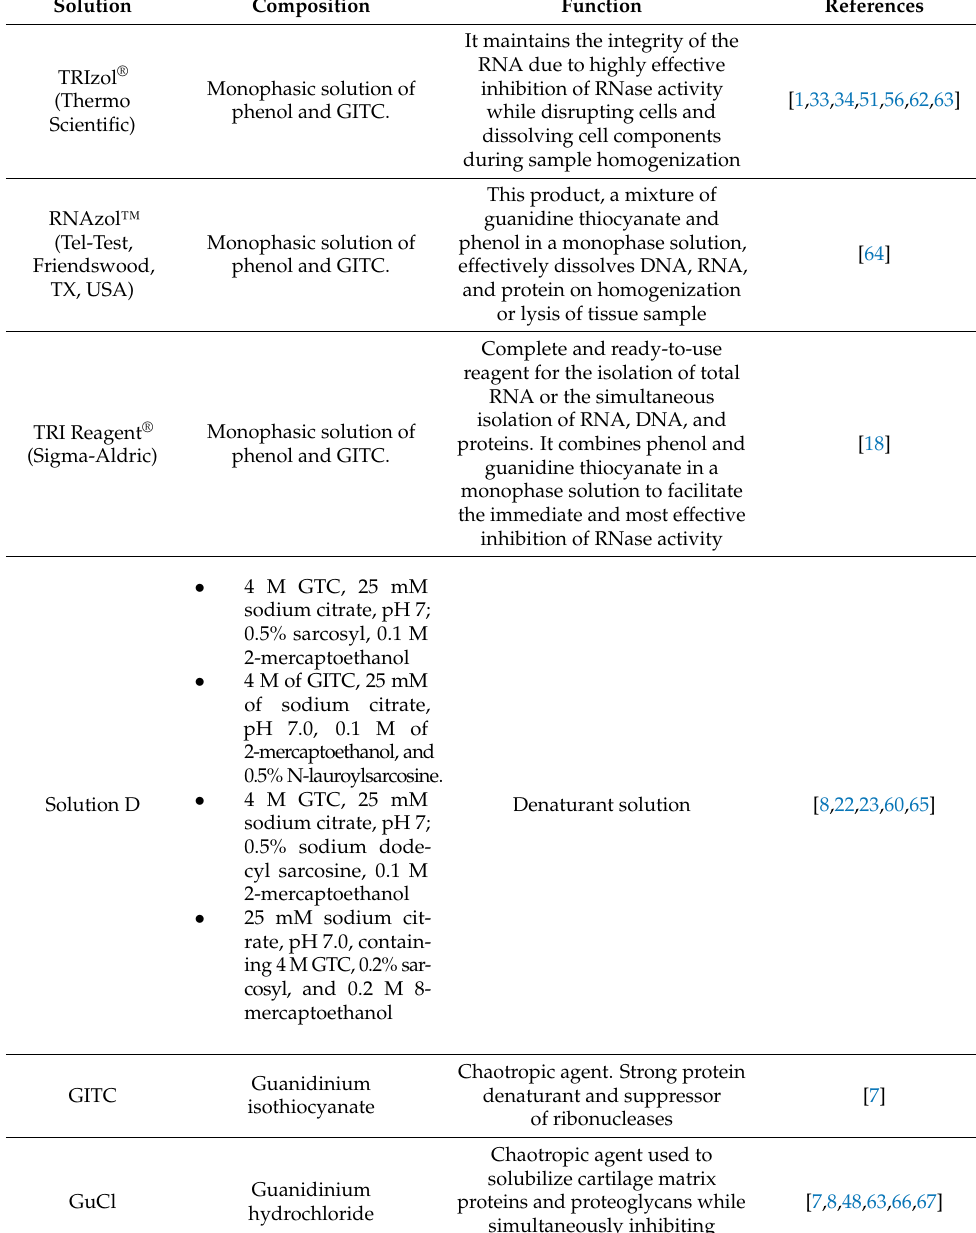
Table 2. Composition and function of the solutions employed in the homogenization